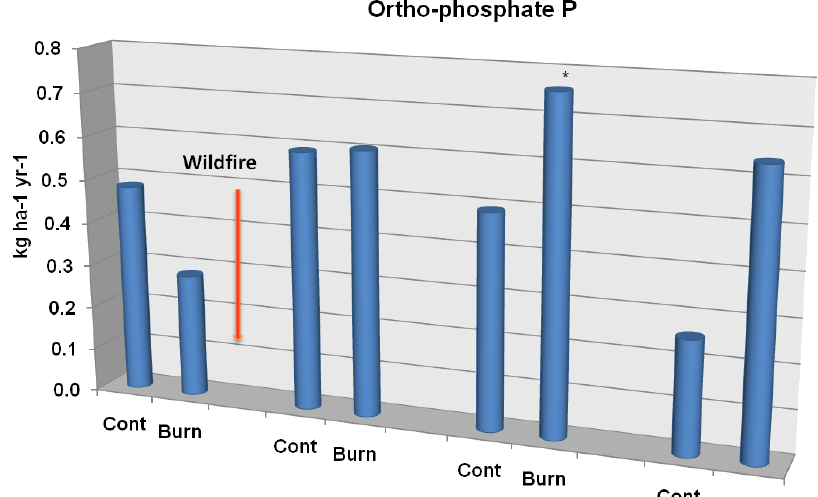
Figure 5B. Ortho-phosphate P soil leaching flux from unburned controls and study plots burned by wildfire. Significant differences are noted as p < 0.10 (*), p < 0.05 (**), or p < 0.01 (***). Adapted from